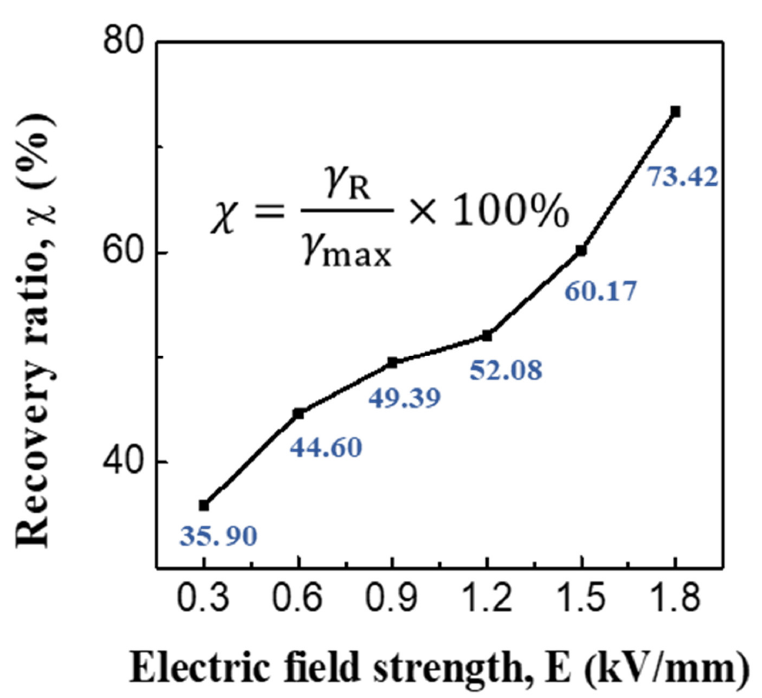
Figure 13. Recovery ratio vs. electric field strength of GO/PDPA microsheet composites-based ER fluid (10 vol.%).